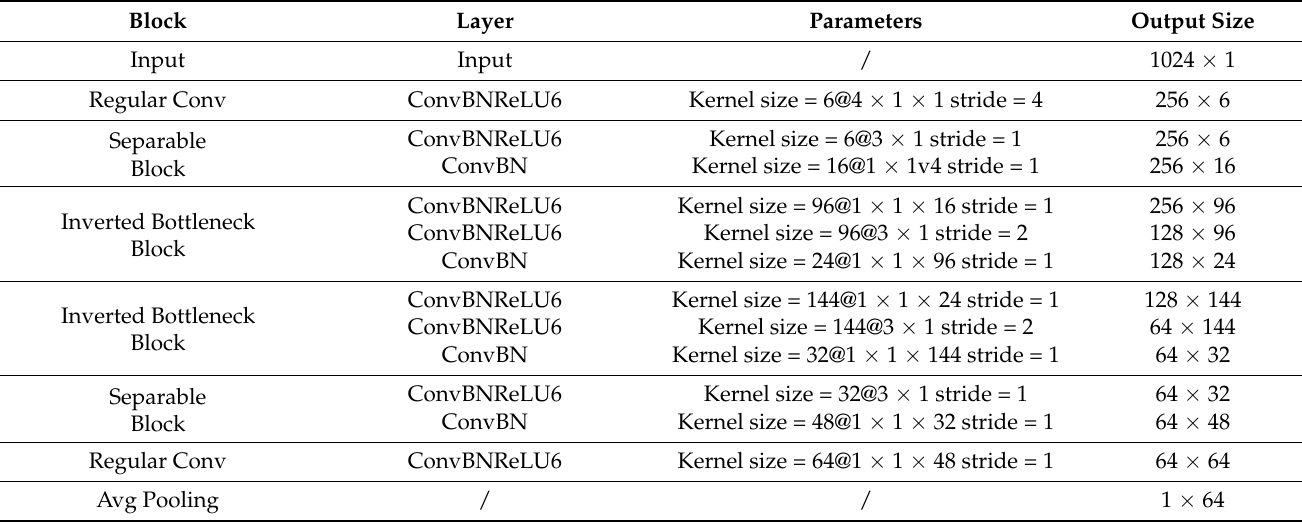
Table 1. Details of feature extraction